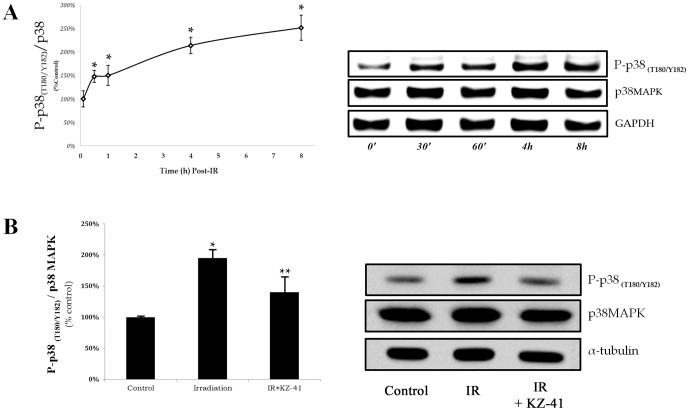
Induction of p38MAPK phosphorylation in irradiated RECs.A) RECs receiving 30 Gy irradiation in a single fraction show increases in phosphorylation of p38MAPK (T180/Y182) that reach a plateau between 4–8 hours compared to control cells at same time-points (*P<0.05). B) Irradiated RECs with or without treatment of KZ-41 (10 µM) were harvested and analyzed for phospho-p38MAPK at 4 hours. KZ-41 treated RECs showed significant reductions in total levels of phosphorylated p38MAPK (T180/Y182), as compared to IR-RECs (**P<0.05).